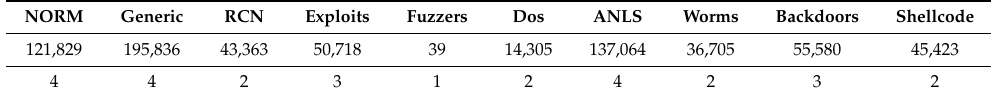
Table 7. Each attack type corresponds to the average rate level.